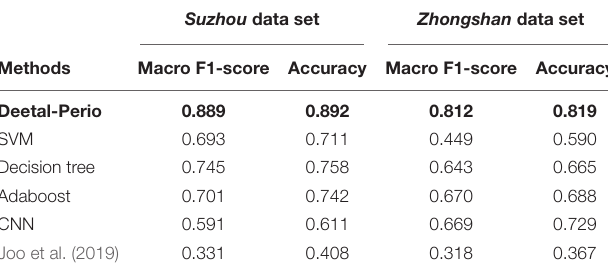
TABLE 2 | Performance comparison tested on the Suzhou data set and Zhongshan data set between Deetal-Perio and five methods by F1-score and accuracy on the periodontitis prediction task.